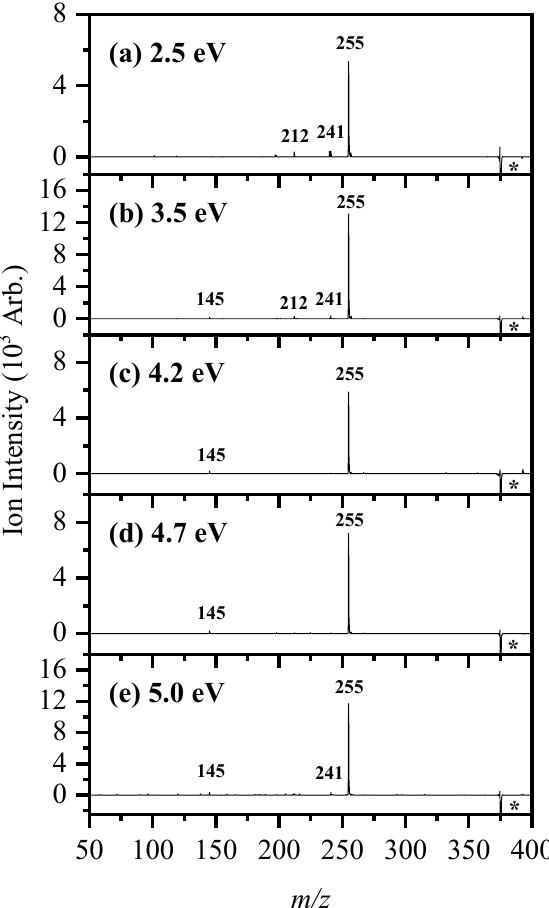
Figure 3. Photofragment difference (laser ON —laser OFF ) mass spectra of [RF − H] − ⋅ excited at five photodepletion maxima of ( a ) 2.5, ( b ) 3.5, ( c ) 4.2, ( d ) 4.7, and ( e ) 5.0 eV. [*] indicates the photodepleted parent ion signal at m / z 375.